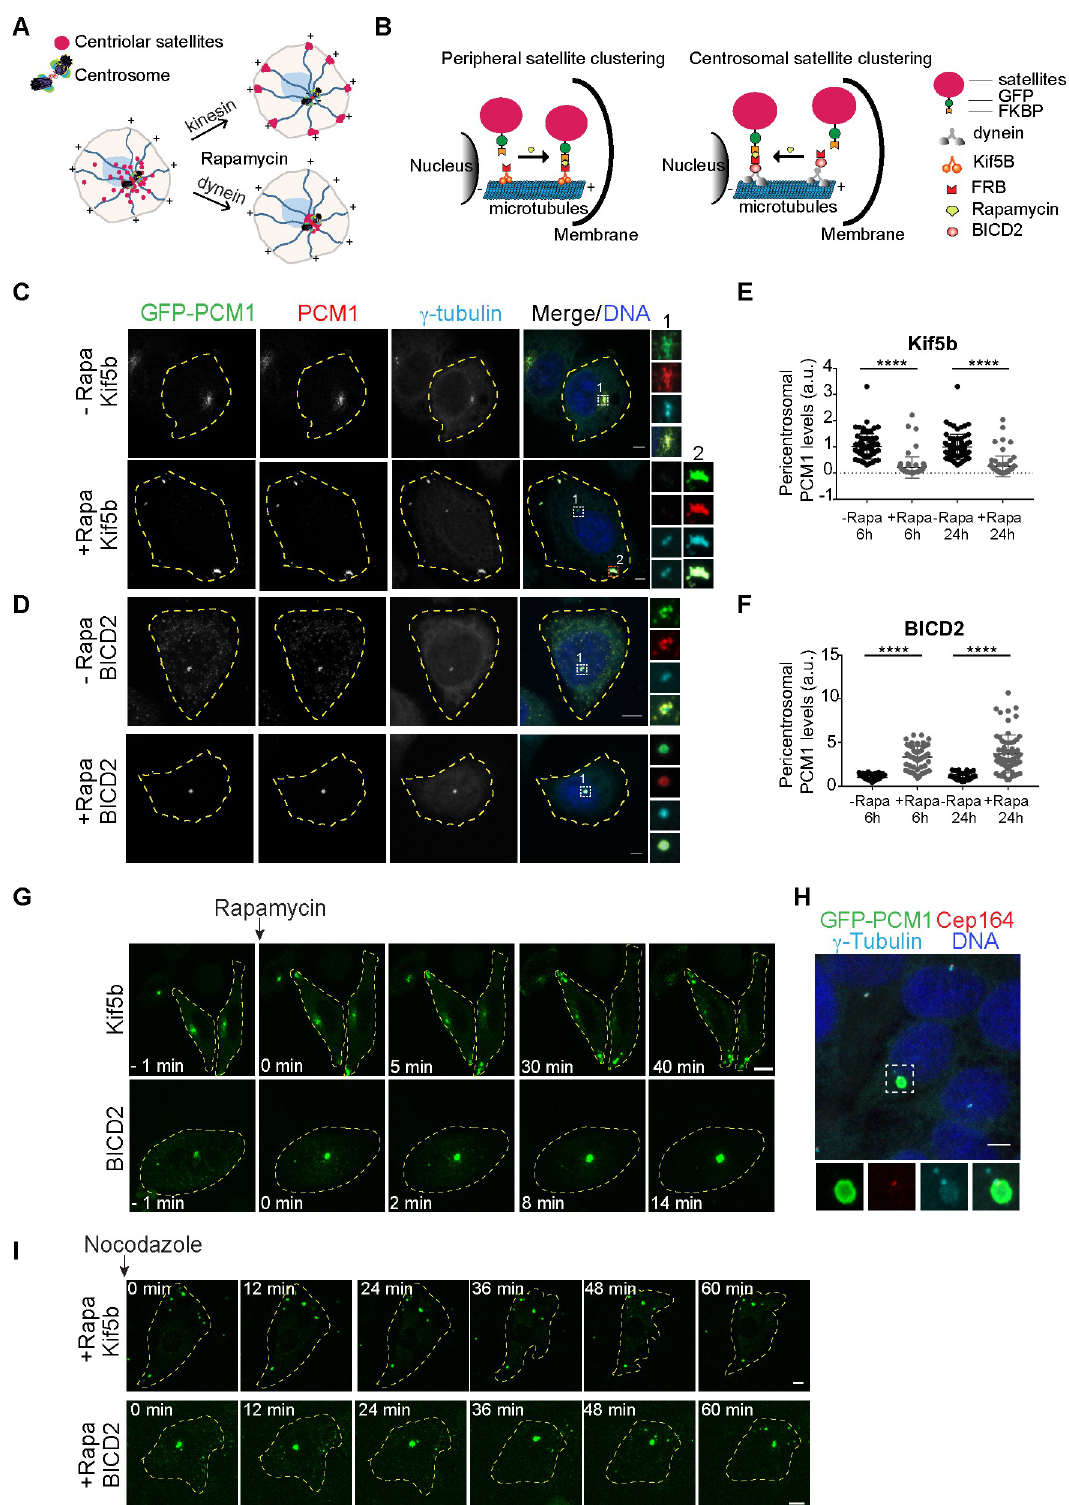
Fig 1. Inducible dimerization of PCM1 with constitutively active motor domains targets satellites to the cell periphery or center. Development and validation of the inducible satellite trafficking assay. (A) Representation of satellite redistribution to cell periphery or center upon inducible dimerization of the satellite scaffolding protein PCM1 with the constitutively active plus